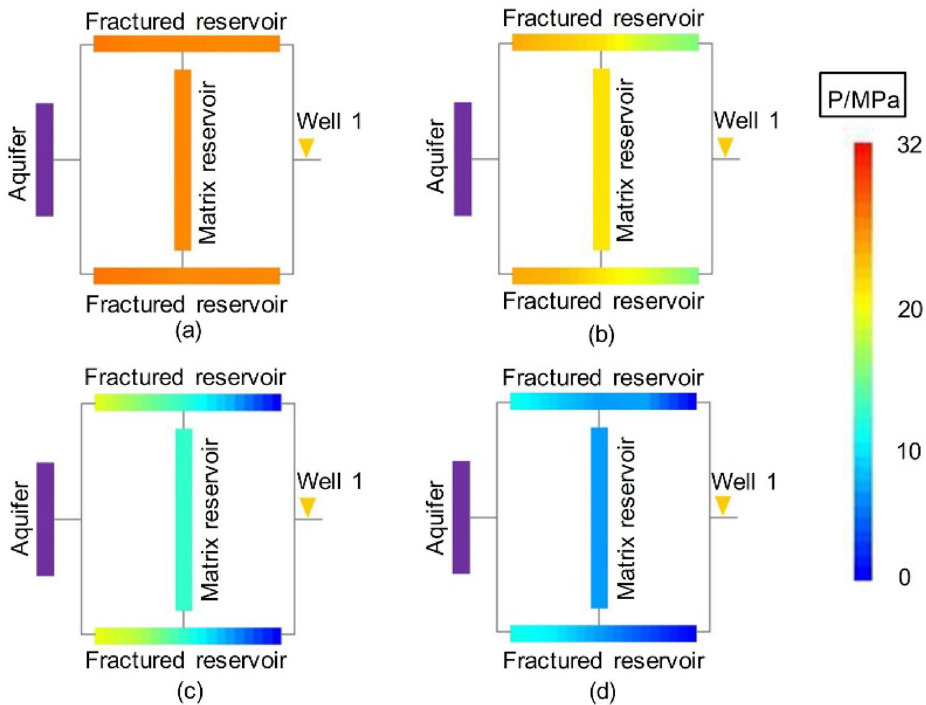
Figure 10. Pressure distributions at different stages of Experiment 1-3: ( a ) early stage of production—10 min, ( b ) early stage of production—20 min, ( c ) end of the stabilized period—32 min, and ( d ) production halts— 115